Question: Compose a caption that would accompany this figure in a paper.
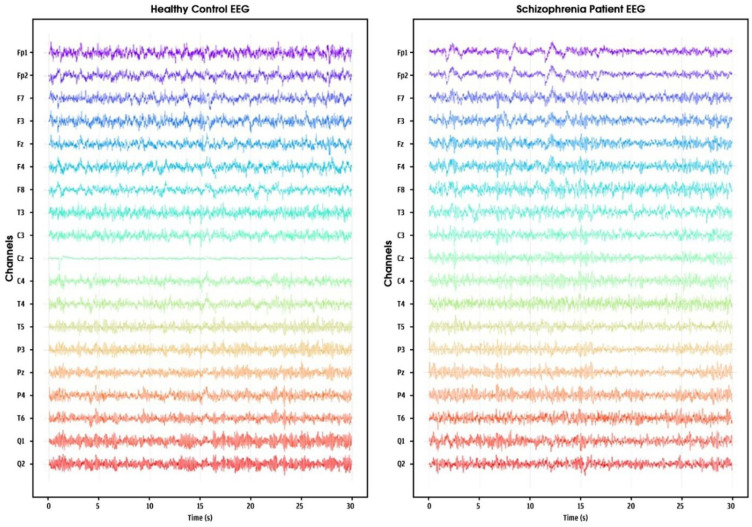
Answer: Comparative EEG waveform analysis of healthy controls vs. schizophrenia patients.